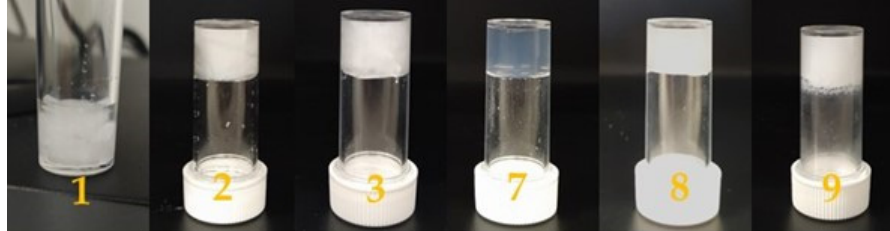
Figure 2. Photographs of hydrogels 1 – 3 and 7 – 9 .